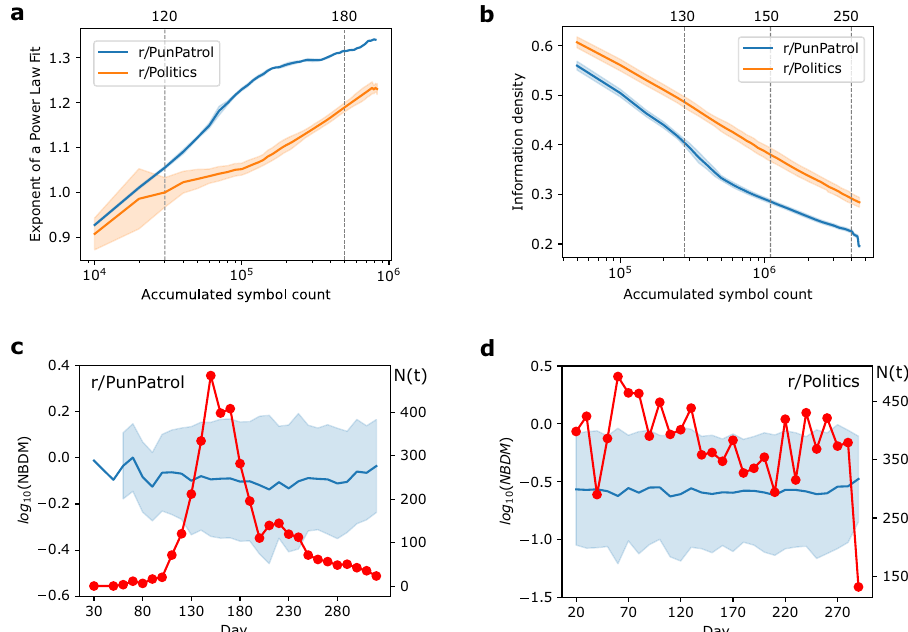
Fig. 7 Evolution of multi-scale diversity in the online communities. a Zipf's law exponent evolution for a given accumulated word count in the online communities r/PunPatrol (blue) and r/Politics (orange). Solid line represents the average exponent of 25 replicate sub-samplings, and shaded region encompasses one standard deviation of this distribution. b Decay of information density for varying number of accumulated symbols in the r/PunPatrol (blue) and r/Politics (orange). Solid line represents the average information density of 25 replicates within-year orderings, and the shaded region encompasses one standard deviation of the distribution. The evolution of log-transformed size-normalized structural complexity (NBDM) in c r/PunPatrol and d r/Politics. As a guide, the red line indicates the cultural product diversity N ( t ) in each domain for c and d